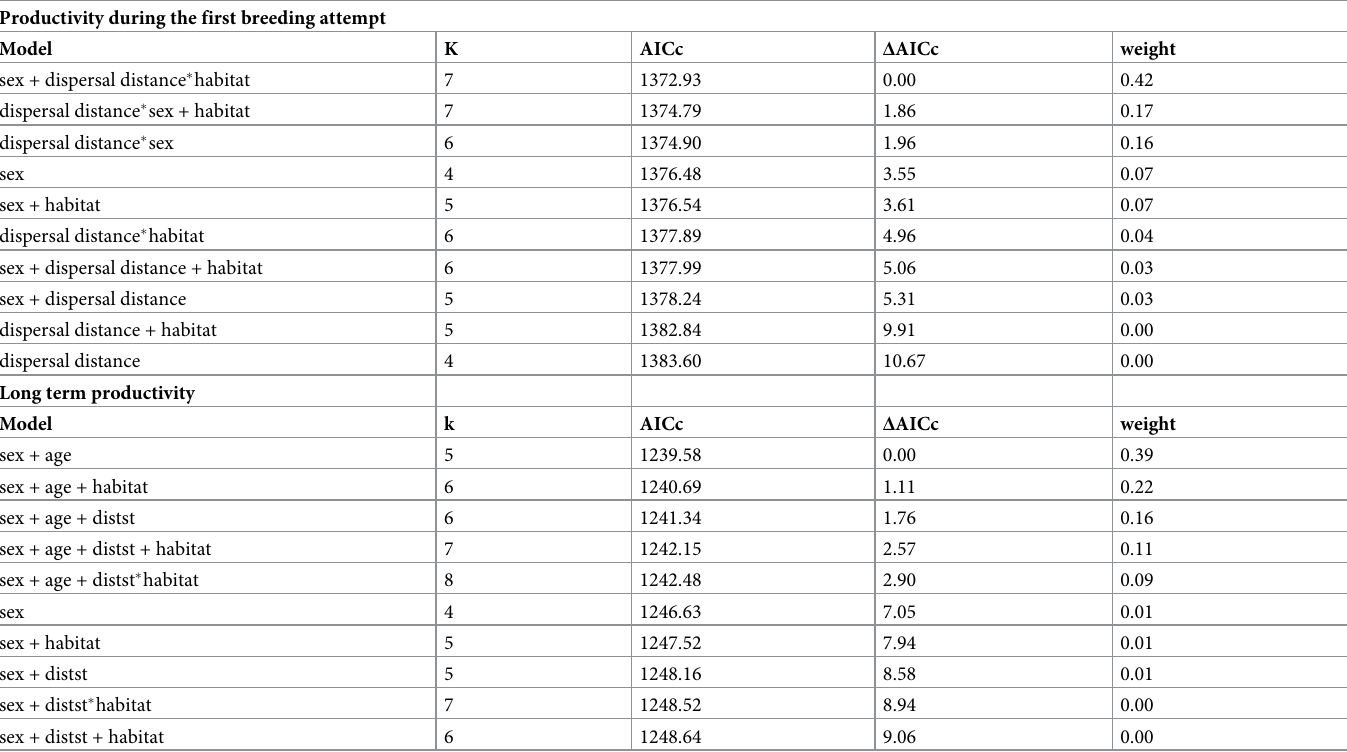
Table 3. Models obtained to assess the relationship between natal dispersal distances and productivity during the first breeding attempt, and long term productivity of rural and urban (habitat) burrowing owls Athene cunicularia . All models were run including year as a random term; models for long term productivity also included individual as a random term. Models shown are the first 10 models ranked using their AICc. K: number of estimated parameters in approximating model, AICc: Akaike information criteria with small sample bias adjustment, Δ AICc: difference between each model and the best model (i.e., the model with the lowest AICc), weight: Akaike weight.